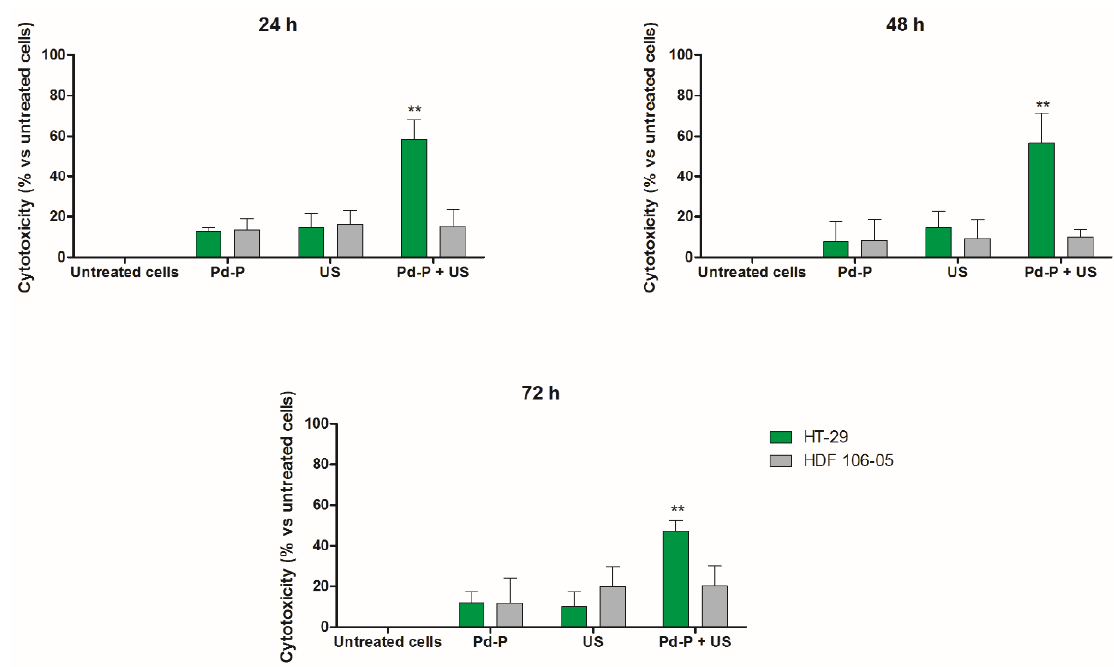
Figure 3. Effect of sonodynamic treatment on HT-29/HDF 106-05 co-culture. HT-29 and HDF 106-05 cells, in a 1:1 co-culture, were incubated for 24 h with Pd-P (500 µ M), and then exposed to US (1.5 W/cm 2 at 1.866 MHz, for 5 min). Cytotoxicity was then evaluated after 24, 48 and 72 h by counting HT-29 and HDF 106-05 cells. Data are expressed as percentage of cytotoxic treated cells versus untreated condition. Statistically significant difference versus untreated cells: ** p < 0.01.